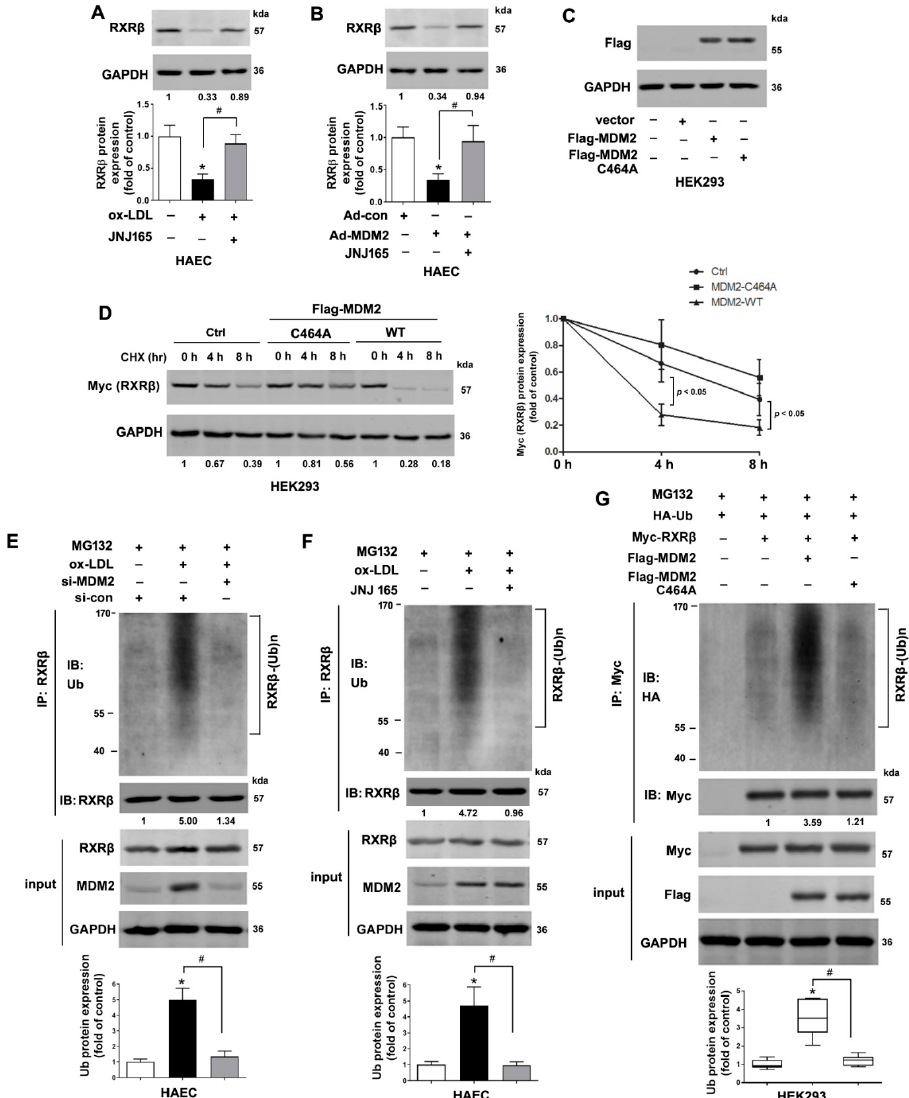
Figure 3. MDM2 mediates the poly-ubiquitination of RXR β . ( A ) HAECs pretreated with JNJ-165 (10 µ M) or vehicle for 1 h were incubated in the presence and absence of ox-LDL (100 µ g/mL) for 24 h. Then, protein expression of RXR β was determined. ( B ) HAECs were incubated with a